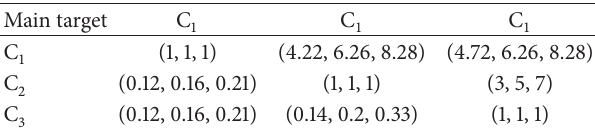
Table 2: Criteria concerning the main